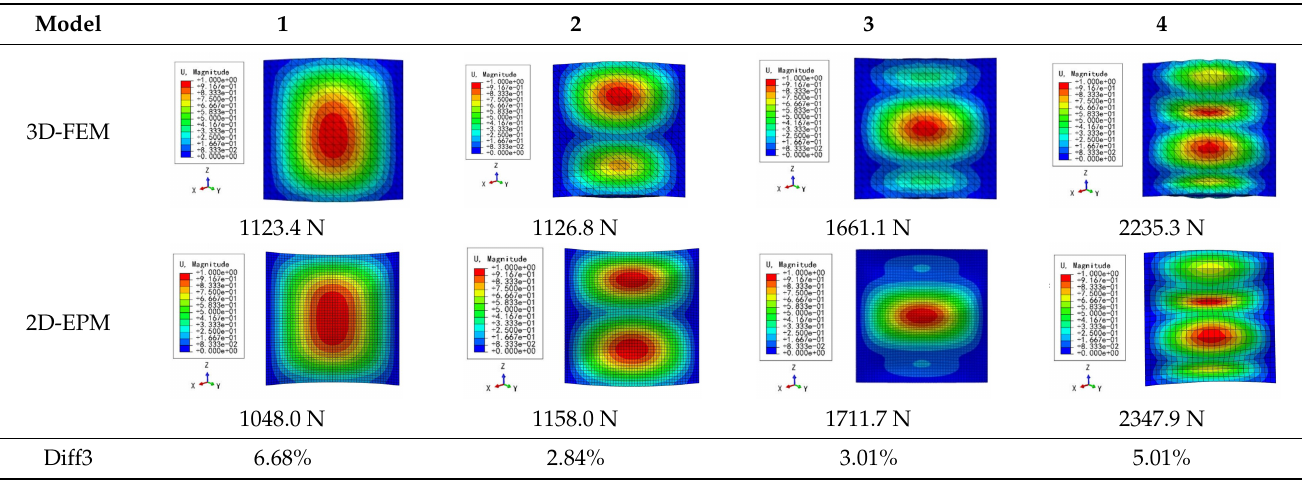
Table 3. Comparison of the buckling modes and buckling loads of the triangular HSP under simply supported boundary conditions predicted by different